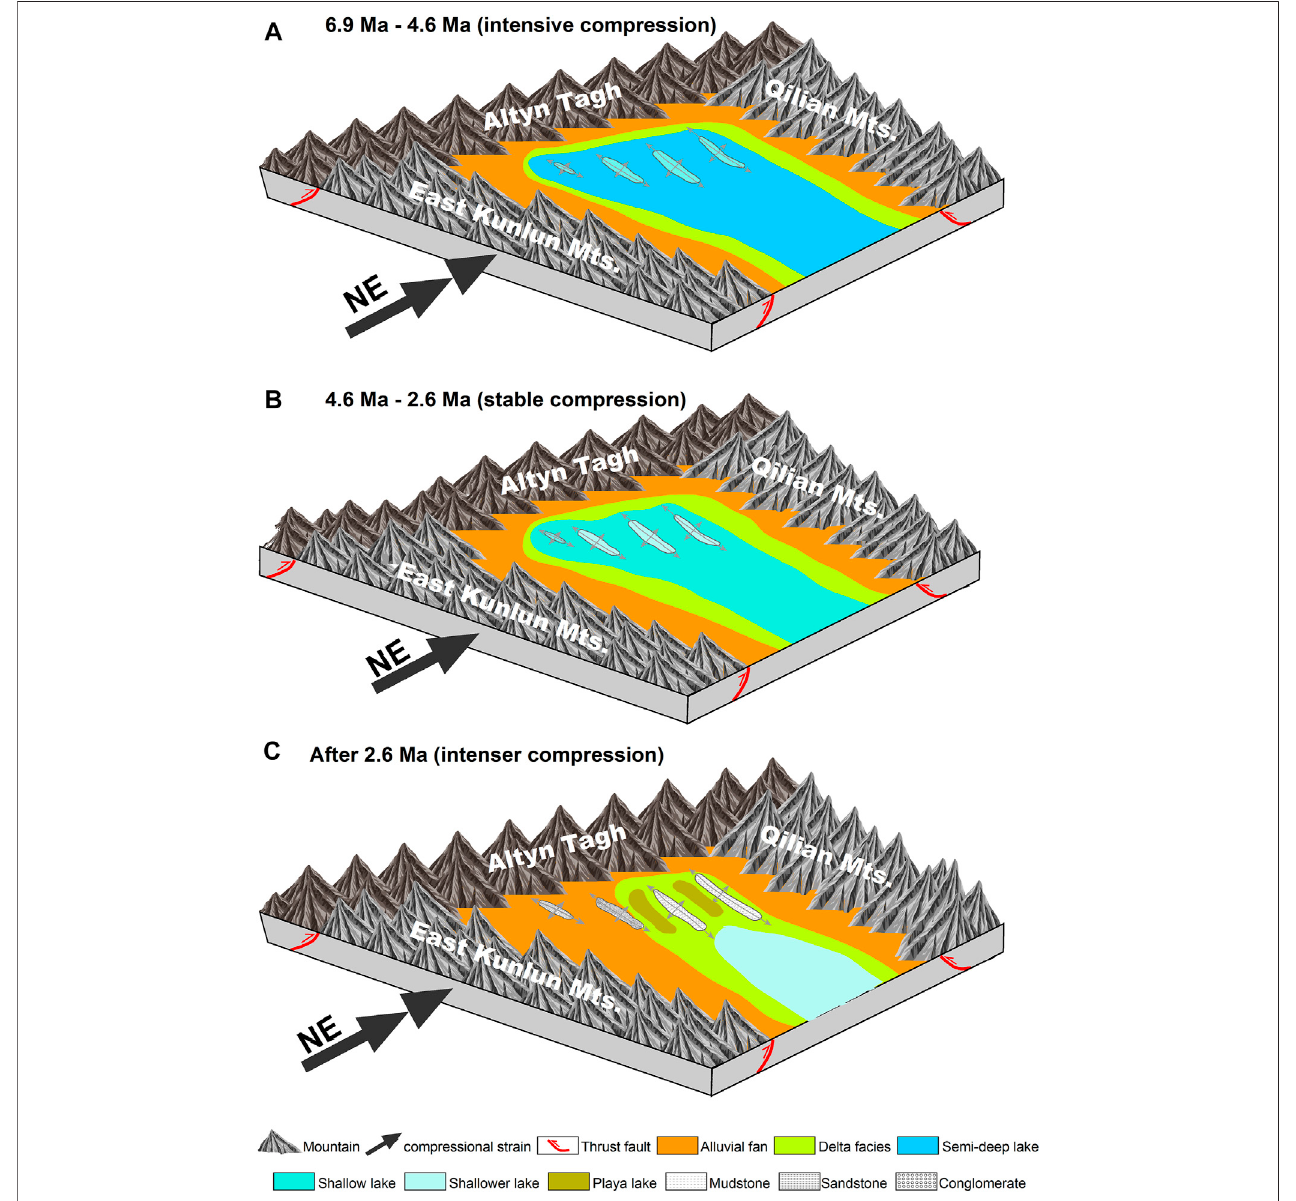
FIGURE4| Threetectonicstagesinferredfromtheanisotropyofmagneticsusceptibility(AMS)oftheQigequanpro fi leillustratingtheevolutionofthelithofaciesand the lake shrinking at the intense compressional stage between ~6.9 Ma and 4.6 Ma (A) , the stable compressional stage between 4.6 Ma and 2.6 Ma (B) and the relatively more intensive compressional stage after 2.6 Ma (C)